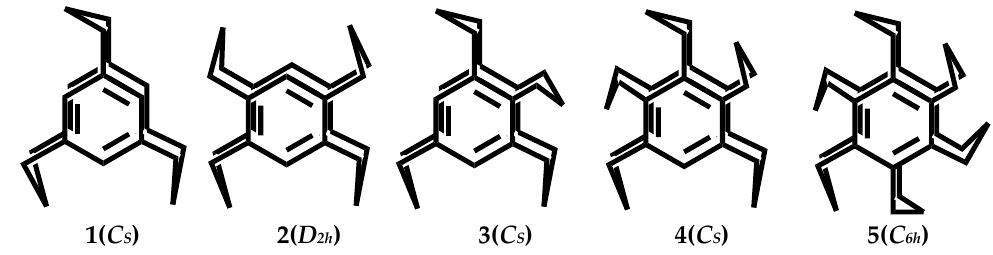
Figure 3. The most secure conformers of multibridged [3 n ]CPs (n = 3–6).